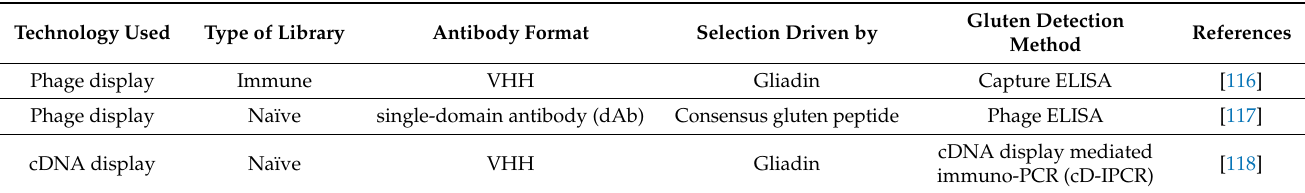
Table 5. Several examples of directed evolution methods for the obtention of antibodies for detection of gluten in foods. Technology